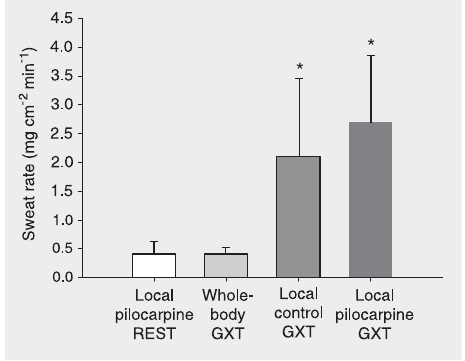
Figure 1. Whole-body and local sweat rates at rest (REST) and during graded exercise tests until exhaus- tion (GXT). Data are reported as mean ± SD for 9 male volunteers. Local pilocarpine REST = sweat rate on the right forearm after 15 min of pilocarpine iontophoresis. Whole-body GXT = whole-body sweat rate during GXT. Local control GXT = sweat rate on the left forearm